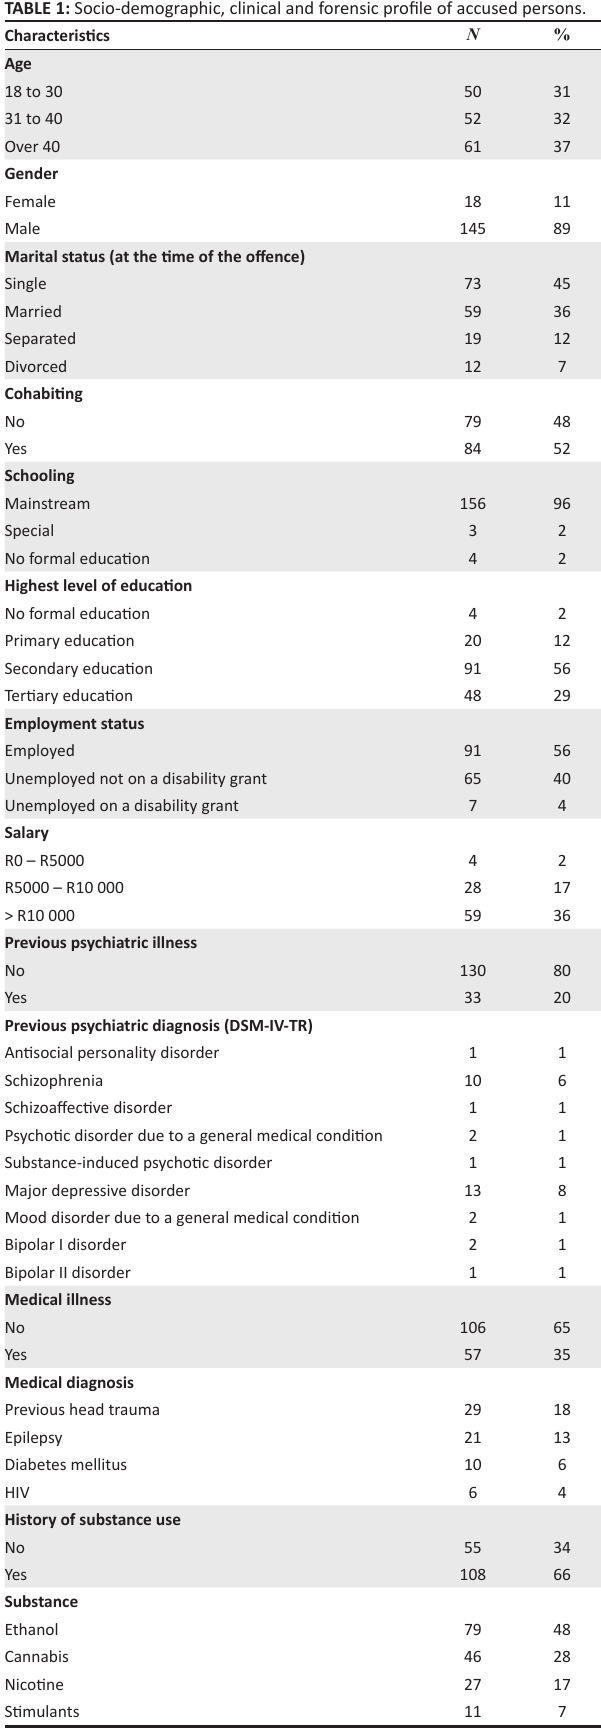
TABLE 1: Socio-demographic, clinical and forensic profile of accused persons.